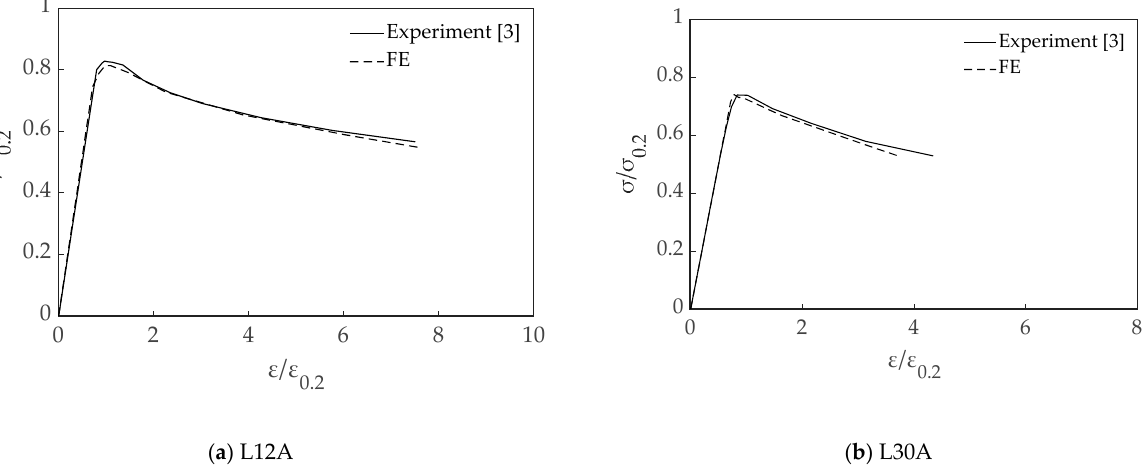
Figure 3. Comparison between typical numerical and experimental [3] response curves.